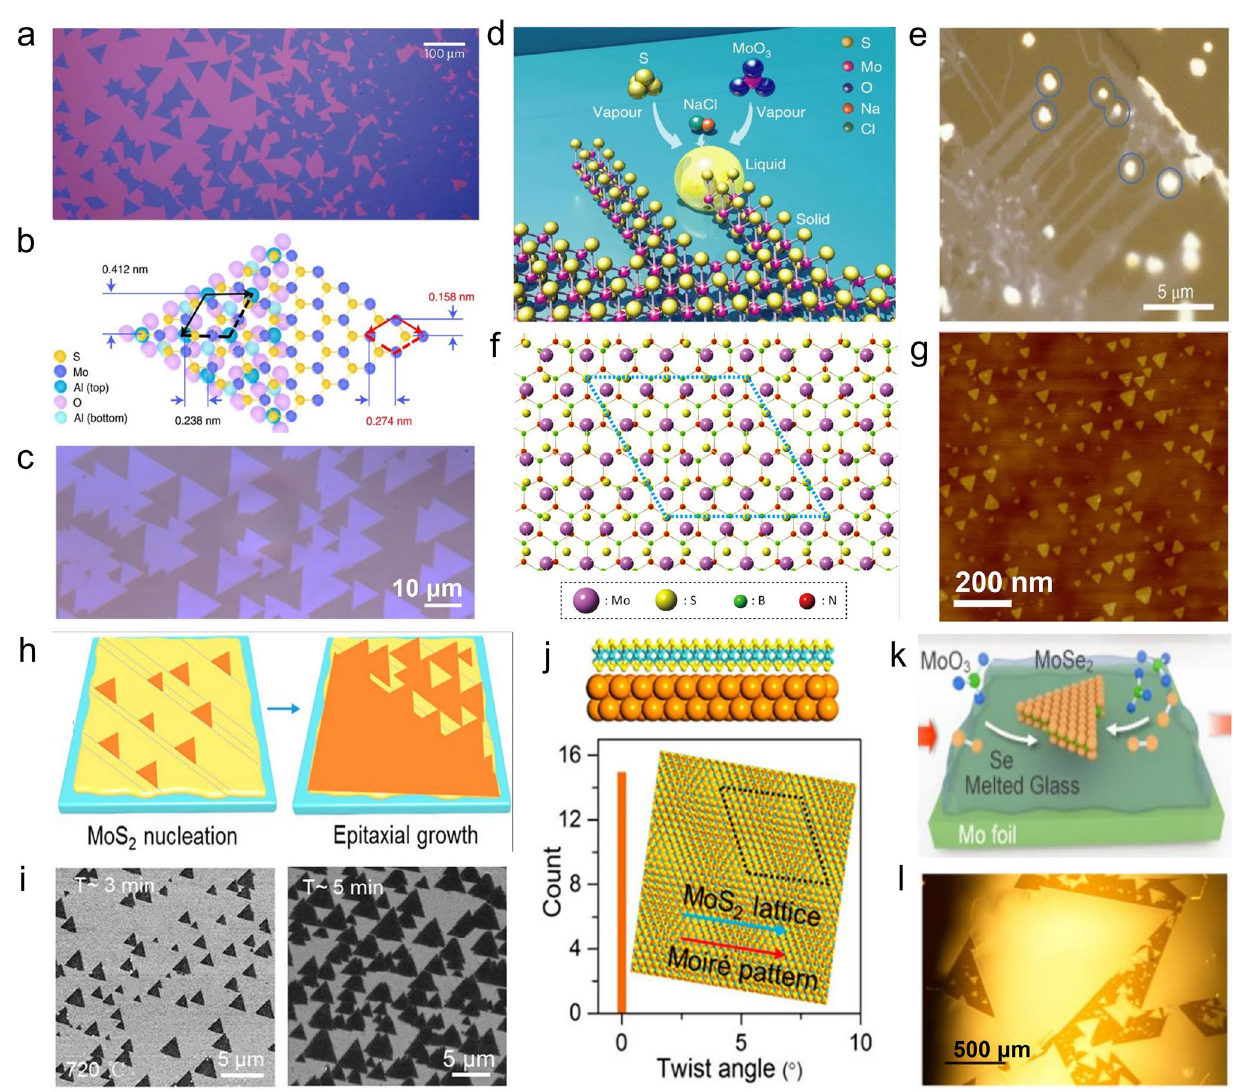
Fig. 8 Influence of growth substrate on the MoS 2 film. a Random distribution and orientation of MoS 2 on amorphous SiO 2 surface [89], Copy- right 2013, Springer Nature. b , c Epitaxially growth of MoS 2 on sapphire substrate [108], Copyright 2021, Springer Nature. d , e Vapor–liquid- solid growth of MoS 2 nanoribbon on NaCl substrate [109], Copyright 2018, Springer Nature. f , g Epitaxially growth of MoS 2 on hBN substrate [110], Copyright 2017, American Chemical Society. h – j Epitaxially growth of MoS 2 on Au substrate [84], k , l growth of MoSe 2 on melted